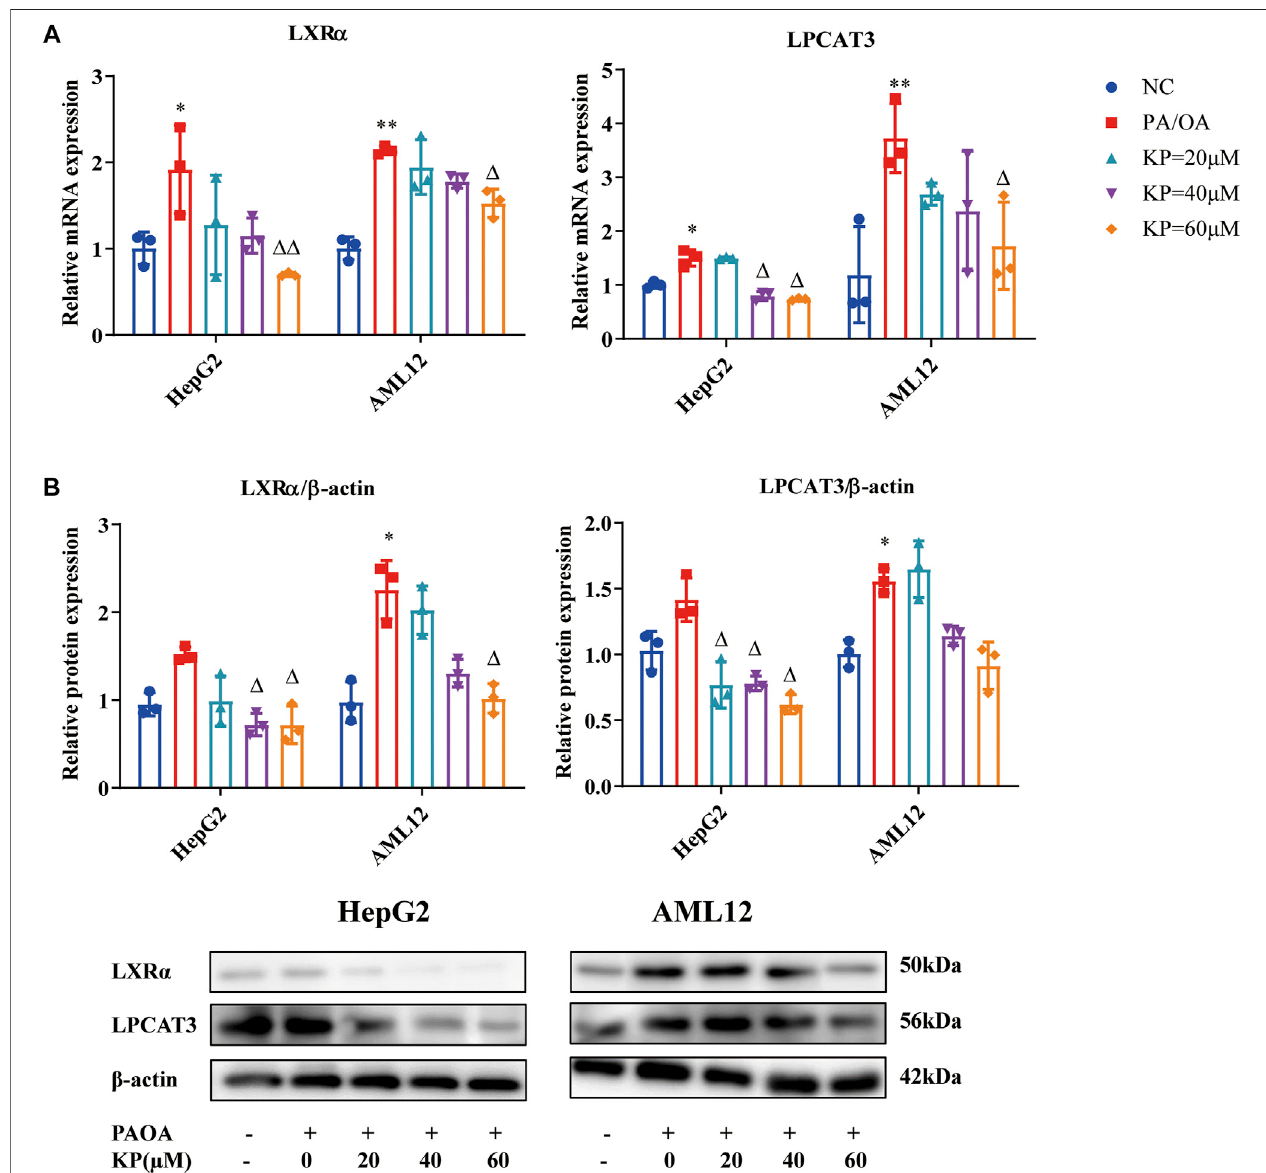
FIGURE5| KP regulated themRNA and protein expression ofLXR α and LPCAT3 invitro . (A) :mRNA level expression ofLXR α and LPCAT3inHepG2 and AML12 cells; (B) :ProteinlevelexpressionofLXR α andLPCAT3inHepG2andAML12cells.NC:Normalcontrolgroup,PA/OA:PA/OAgroup,KP (cid:2) 20 µM:KPlowconcentration group,KP (cid:2) 40 µM:KPmediumconcentrationgroup,KP (cid:2) 60 µM:KPhighconcentrationgroup.Quanti fi cationofmRNAandproteinlevelexpressionwasnormalizedto ß-actin levels. Compared with group NC, *, p < 0.05, **, p < 0.01; Compared with group PA/OA, △ , p < 0.05, △△ , p < 0.01.